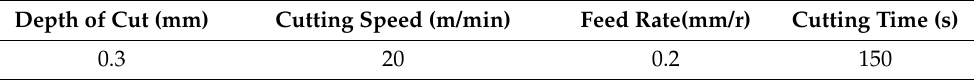
Table 5. Cutting Table 5. Cutting parameters.